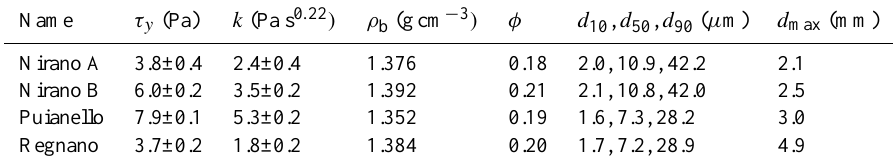
Table 1. Rheological parameters and mud